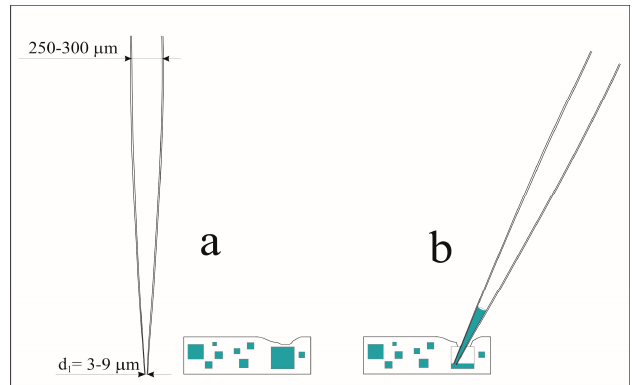
Figure 4. Initial operations of UMCA: ( a ) halite is washed above the selected inclusion; ( b ) extraction of brine with a glass capillary.